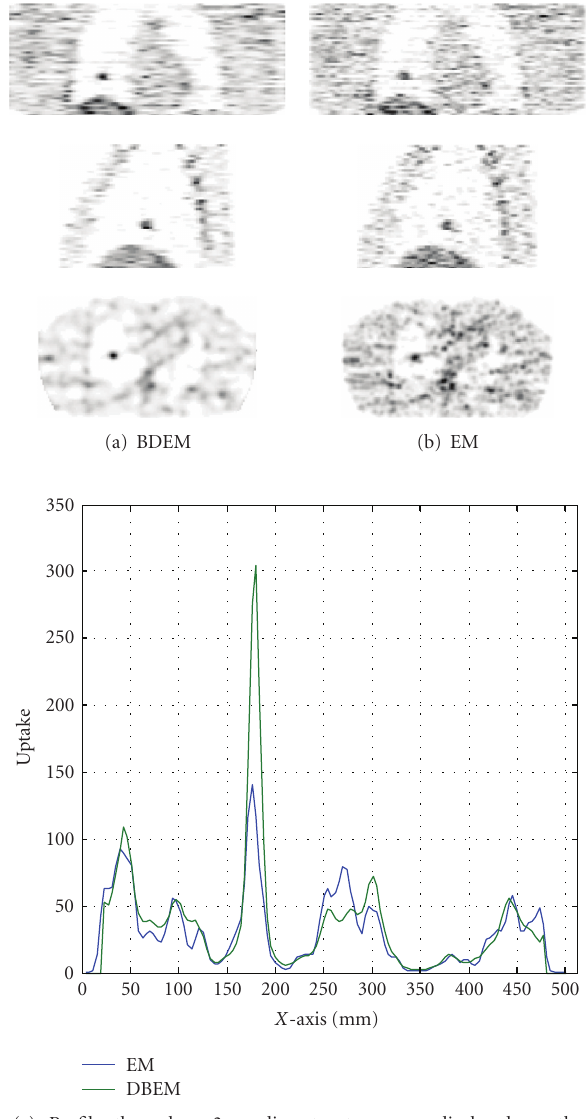
(c) Profile through a 2-cm-diameter tumor as displayed on the transverse view Figure 2: Reconstruction of NCAT utilizing EM and BDEM algorithms. From top to bottom are the coronal, sagittal, and transverse